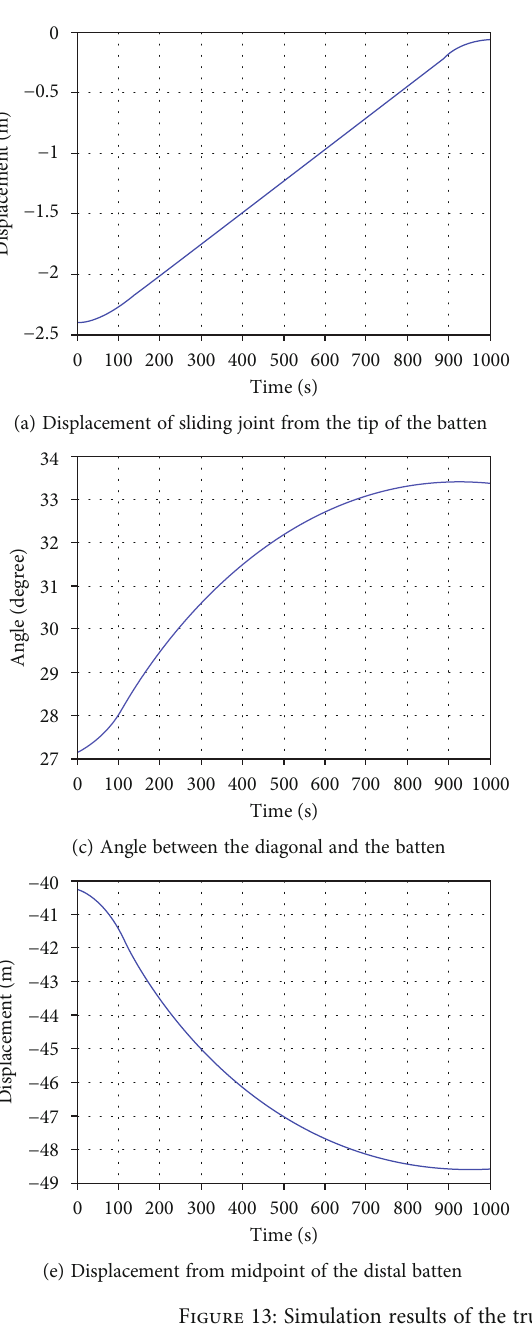
Figure 13: Simulation results of the truss deployment in the second